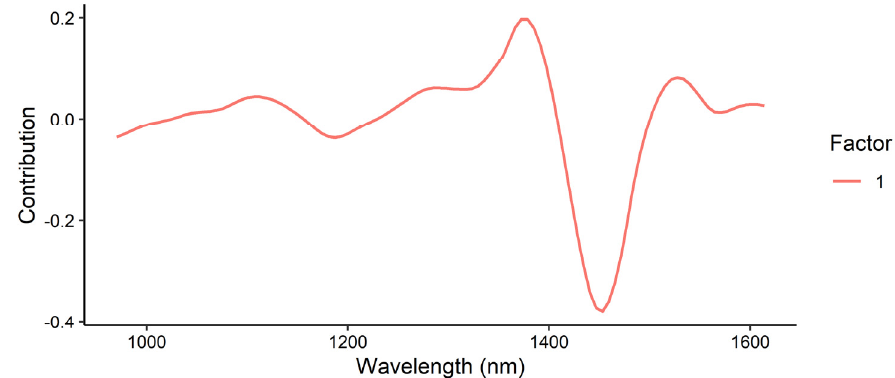
Figure 22. Loadings plot for the prediction of tebuthiuron content using the MicroNIR instrument.